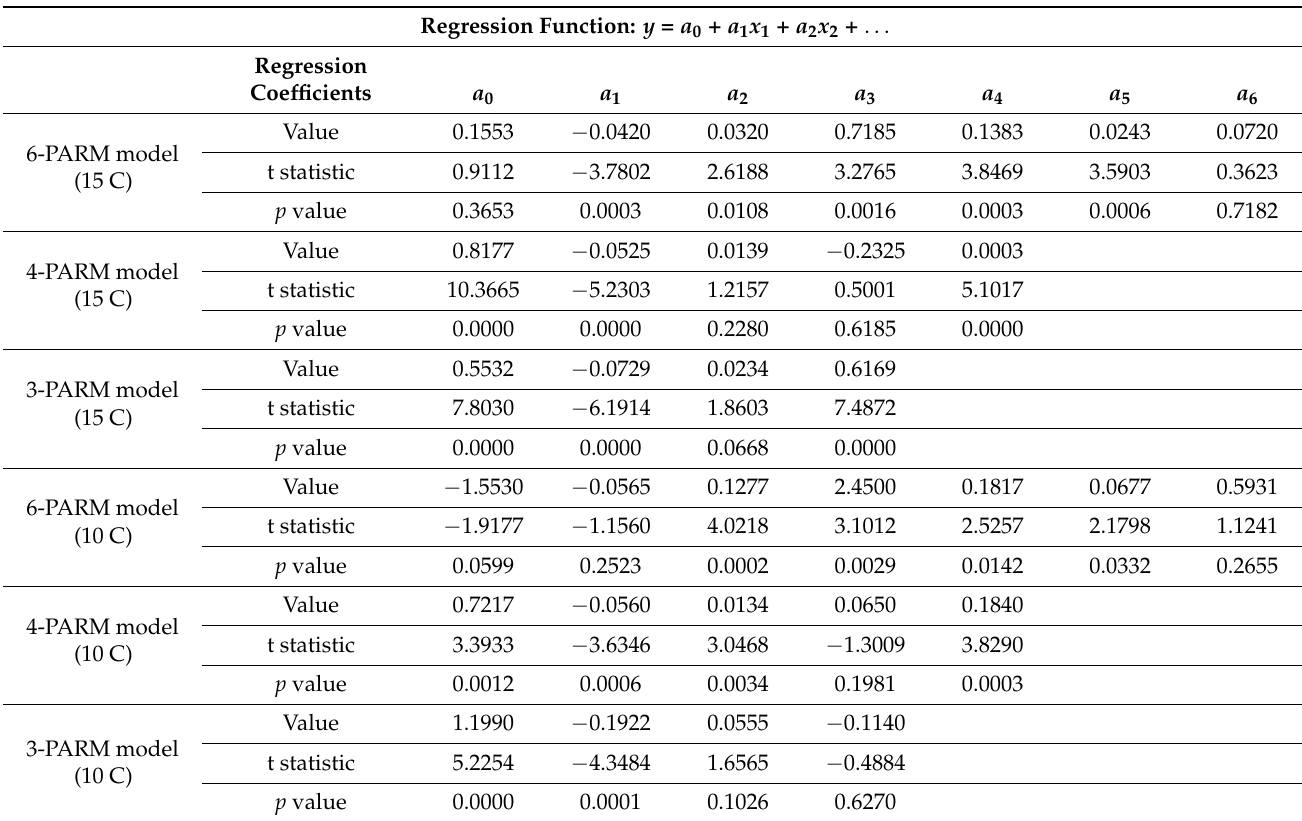
Table A1. The regression value of different coefficients (EIS method).